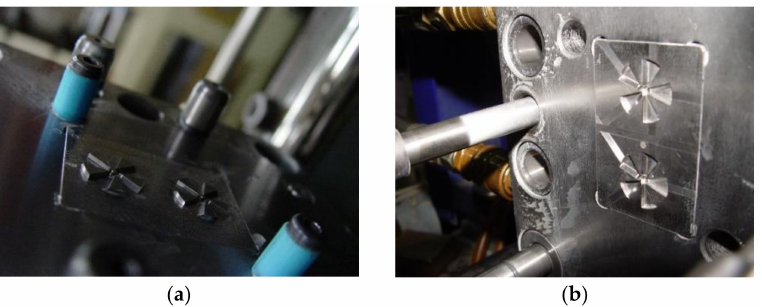
Figure 2. Cavity of the mold insert. ( a ) Cavity for moving part. ( b ) Cavity for stationary part. Table 1. Processing parameters of PIM using POM/ABS/PP/PA/ABS + PC materials.